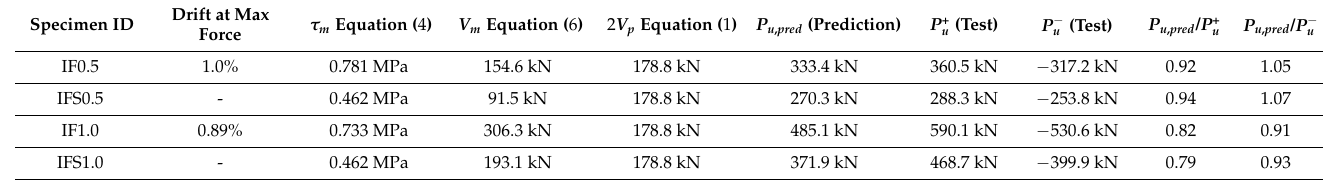
Table 6. Prediction of maximum force based on masonry shear force and flexural yielding of the frame. Specimen